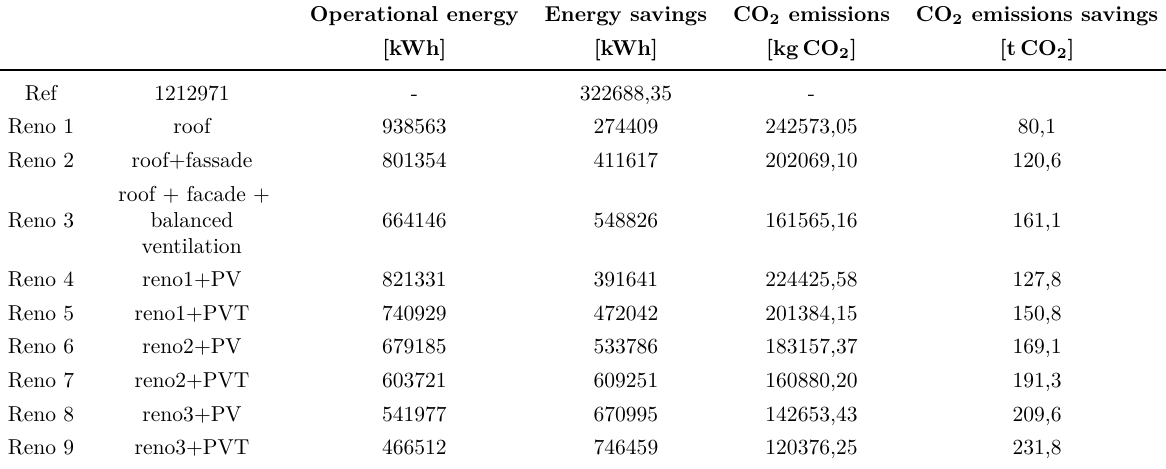
Table 8. Renovation